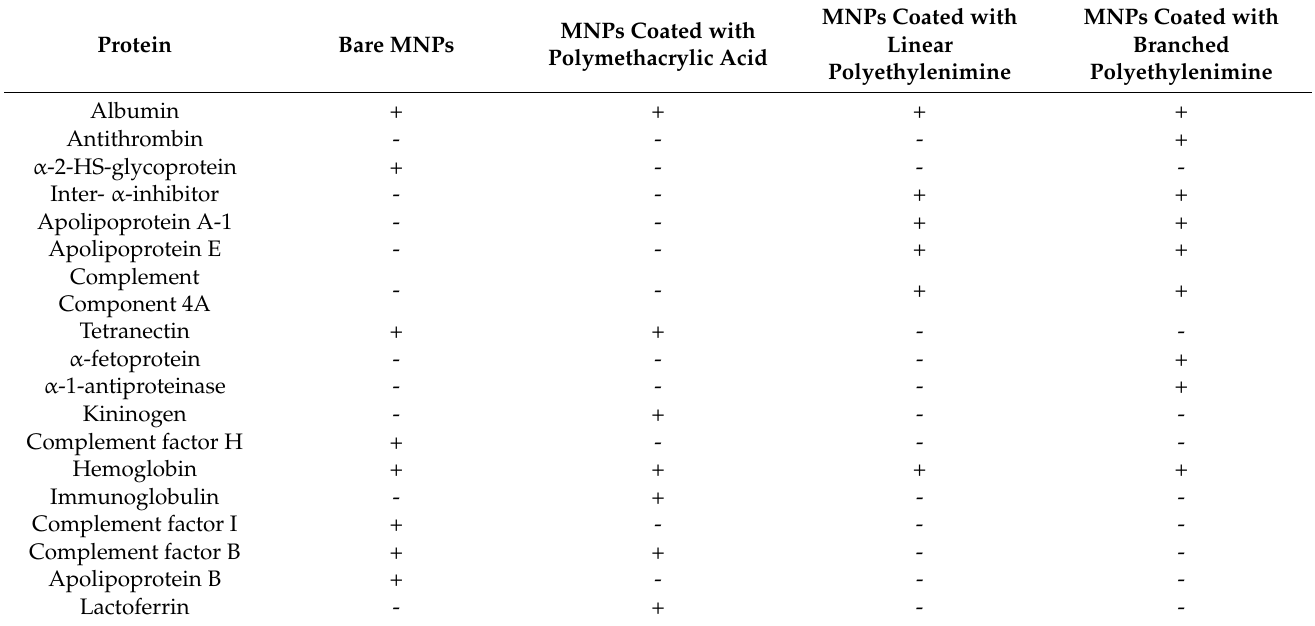
Table 3. Results of LC-MS/MS analysis checking which of the FBS proteins remain on the surface of bare MNPs and MNPs functionalized with polymethacrylic acid, linear polyethylenimine, and branched polyethylenimine after MNPs have been contacted with biological solution containing 10% FBS